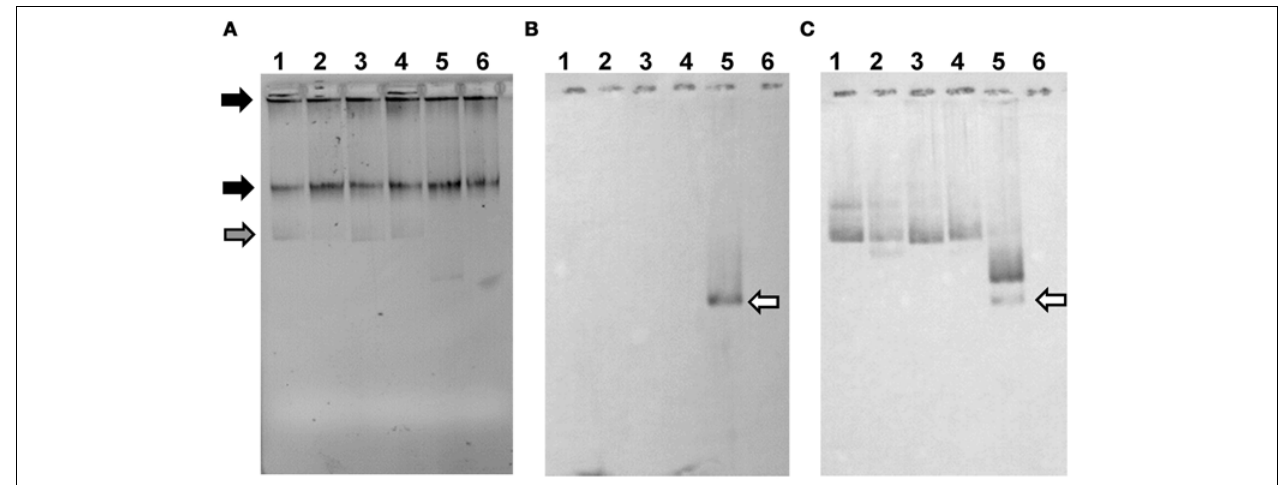
FIGURE 5 | pIJ303 (cid:2) spdA2 and pIJ303-sps do not accumulate single-stranded plasmid DNA. Approximately 10 6 protoplasts of S. lividans TK54 with respective plasmids were lysed in a 1% TA agarose gel containing 0.25% SDS (A) . Black arrows indicate chromosomal DNA, while the gray arrow marks ccc-DNA. The gel was either blotted in native state (B) to detect accumulation of single-stranded plasmid DNA,